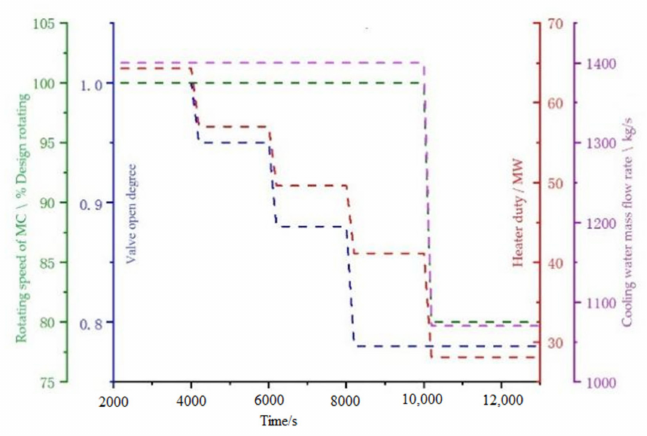
Figure 11. Changes of the parameters in the working load decrease